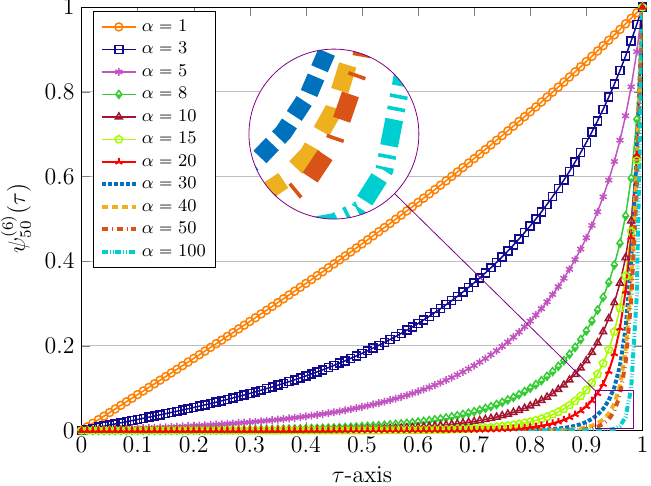
Figure 7. Numerical solutions in QLM-Bessel for M = 50, r = 5, and various α